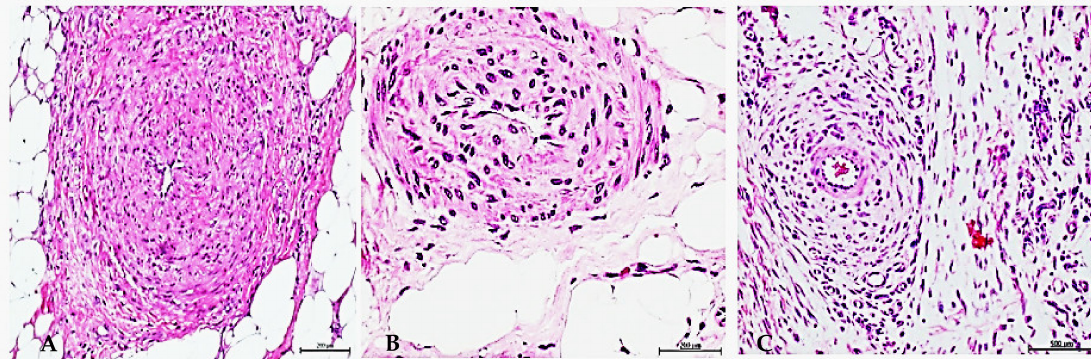
Figure 1. Rats’ arteriolar thickening after exposure to diabetic tissue cell-free filtrate. ( A ) Image showing luminal collapse of arterioles derived from the granulation tissue of a diabetic donor exhibiting intima hyperplasia, media layer thickening, hypercellularity, and concentric collagen of hyaline aspect. H/E. Magnification × 20. ( B ) Rat’s arteriolar walls thickening with luminal collapse in which intima and media layers appear hyperplastic with hypercellularity and fused as a result of infiltrated diabetic tissues homogenate. H/E. Magnification × 40. ( C ) Concentric adventitial collagen accumulation and hypercellularity around an arteriole in a rat treated with diabetic tissues homogenate. H/E. Magnification ×